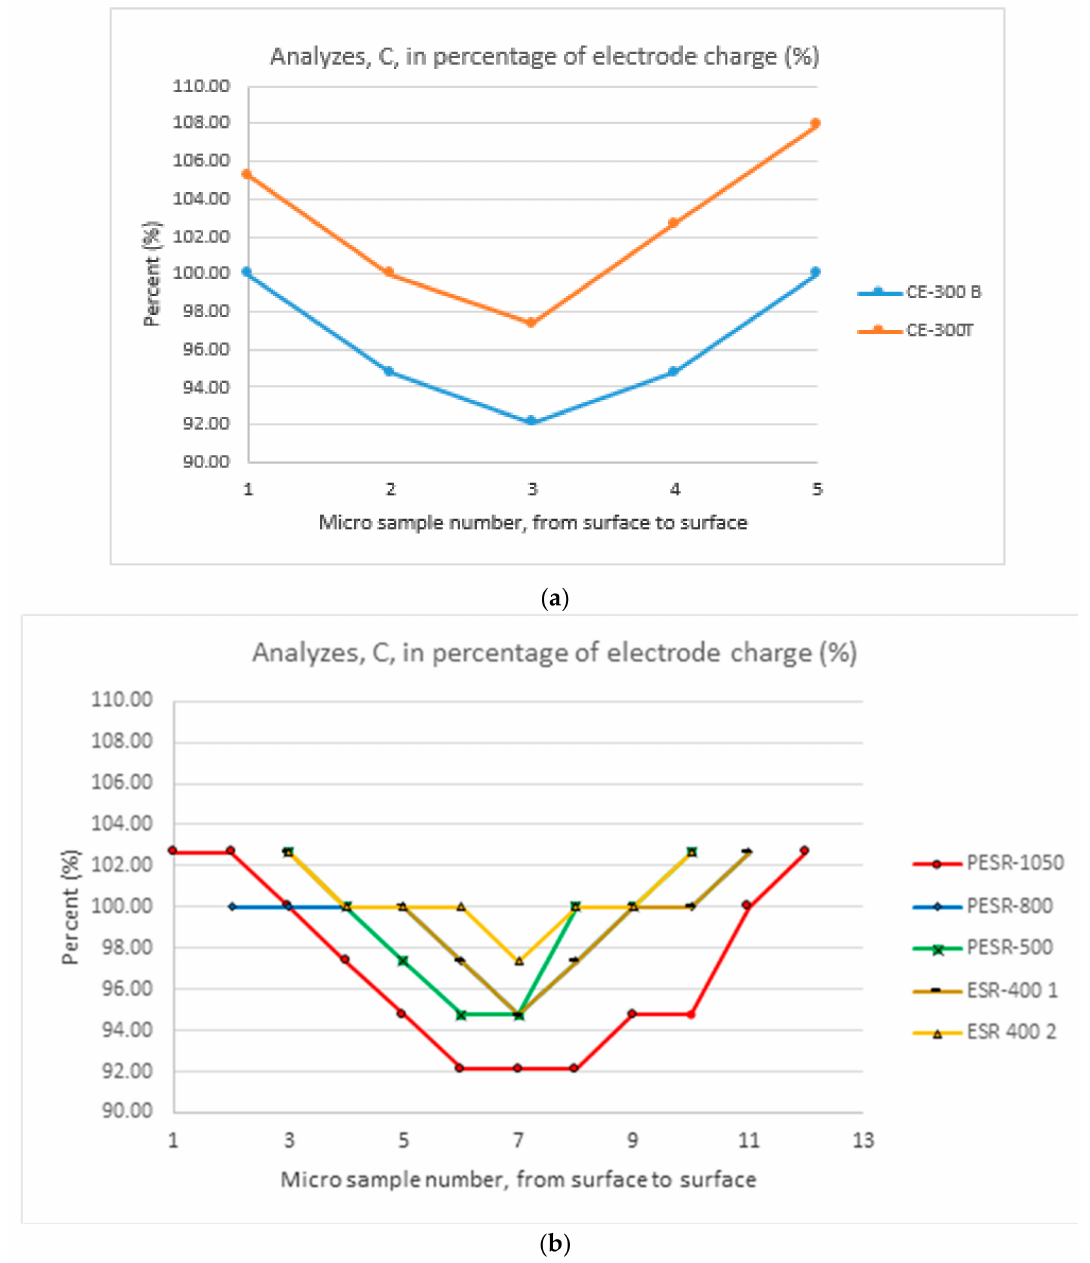
Figure 9. ( a ) The deviations between the amount of carbon (C) at bottom (B) and top (T) of the electrode 300 × 300 mm 2 (C-300) and the corresponding electrode charge. ( b ) The deviations between the amount of carbon (C) in the ingots and their corresponding electrode charges. Electro-slag remelted ingot 400 × 400 mm 2 and pressure electro-slag remelted ingots 500–1050 mm in diameter (PESR-500, PESR-800, and